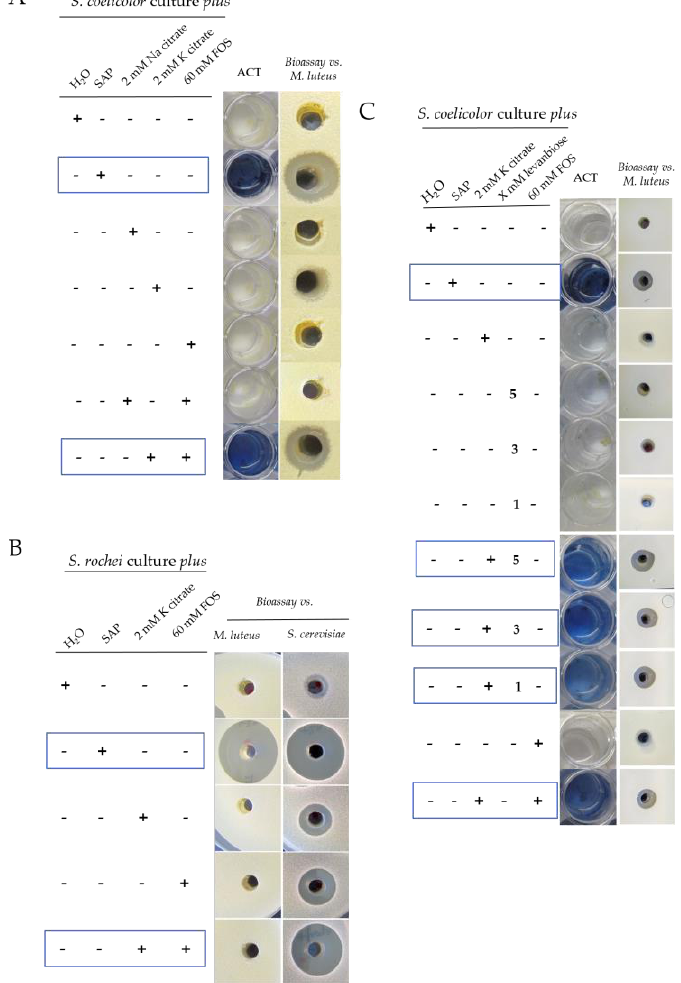
Figure 7. ( A ) Left, ACT production (blue color) by S. coelicolor induced by different combinations of potassium or sodium citrates and FOS in NMMP Medium. Right, bioactivity of 100 µL of the extracts against M. luteus of the indicated samples. ( B ) Antibiotic and antifungal production by S. rochei induced by different combinations of potassium citrate and FOS in NMMP medium. ( C ) Left, ACT production by S. coelicolor induced by different combinations of potassium citrate, levanbiose, and FOS in the NMMP. Right, antibiotic activity against M. luteus of the indicated samples. Negative control: NMMP + H 2 O; positive control: NMMP + SAP.